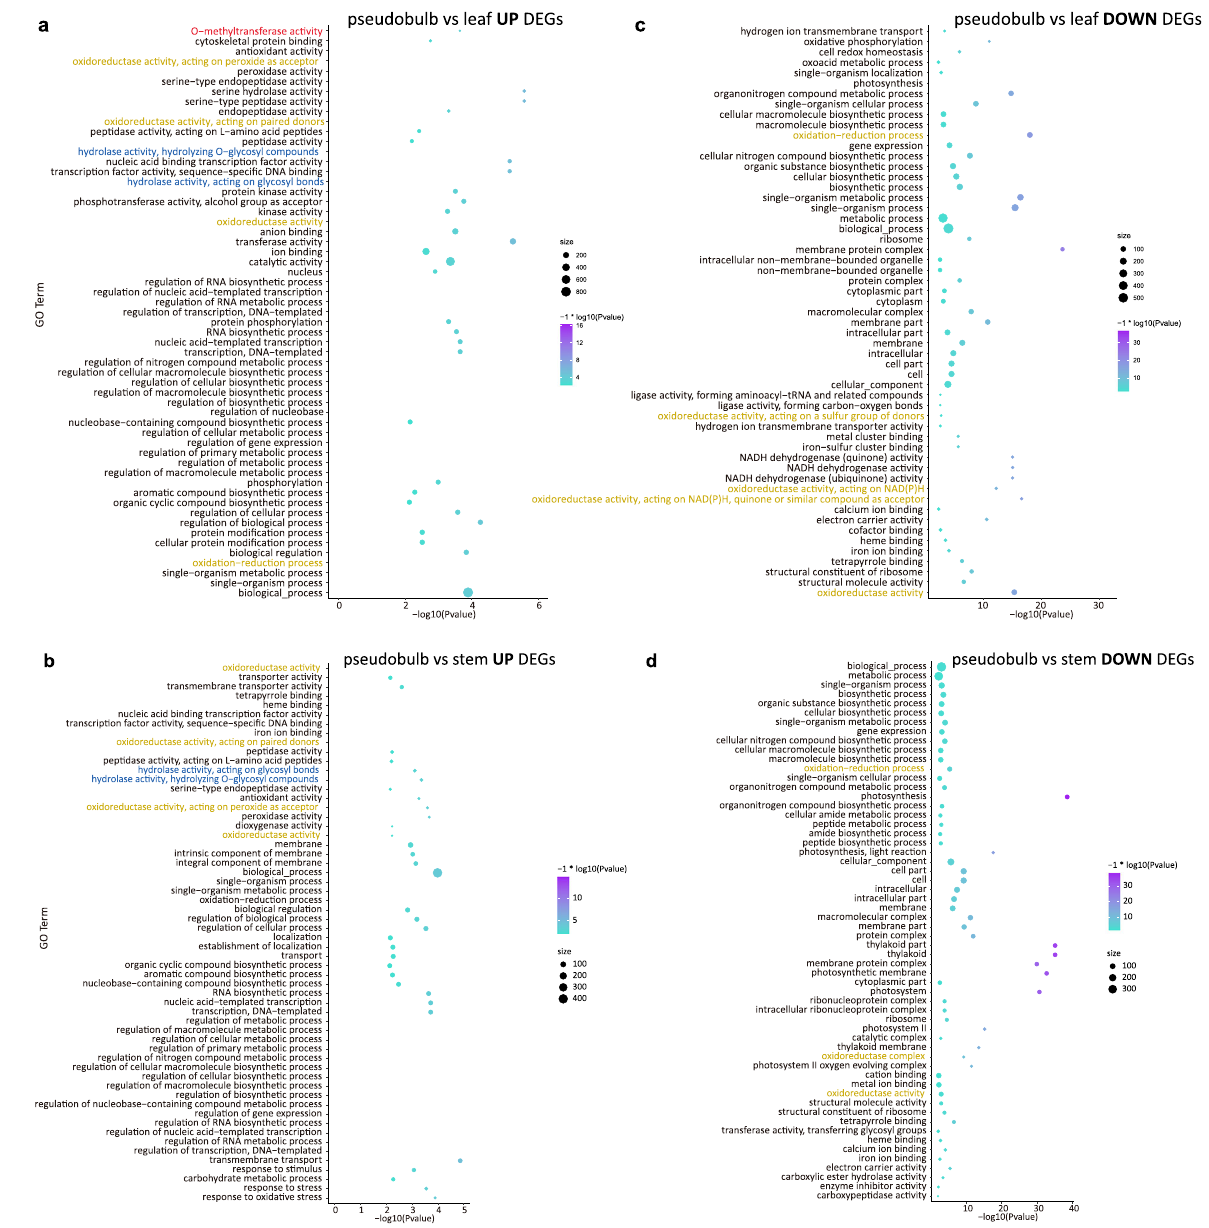
Fig. 6 The GO enrichment analysis of DEGs between pseudobulb vs leaf and pseudobulb vs stem. a , c Up- and downregulated DEGs between pseudobulb and leaf, respectively. b , d Up- and downregulated DEGs between pseudobulb and stem, (v 2.2.6) 64 and GenomeScope 65 were used for k-mer frequency statistics and accurate estimation of genome size respectively. The single Molecule Real Time long-read library was constructed and sequenced on the PacBio Sequel platform (114Gb data, 50-fold coverage of the genome). Long reads were generated for de novo assembly using NextDenovo (https://github.com/Nextomics/NextDenovo) and used NextPolish to fi x base errors in the C. appendiculata genome generated by noisy long reads with a combination of both short read data and long read data (https://github.com/Nextomics/NextPolish). For Hi – C sequencing, a total of 250 Gb (105-fold coverage of the genome) data were generated on the BGISEQ-500 platform. We used juicer pipeline 66 for generating Hi-C maps and 3D de novo assembly (3D-DNA) pipeline 67 with generated Hi – C linking information to create accurate genome assemblies with chromosome-length scaffolds. Using the RNA sequencing data from three different C. appendiculata tissues (leaves, stems, and pseudobulbs) to map back to our assembled genome, and most of the samples reached a 90%~ mapping rate.